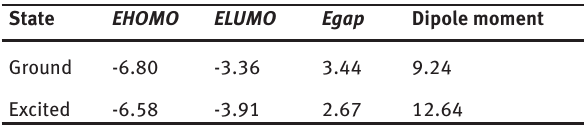
Table 1: HOMO energies ( EHOMO ), LUMO energies ( ELUMO ), HOMO- LUMO energy gap ( Egap ) in (eV) and dipole moment (in Debye) for PBA computed at the B3LYP/6-31G** level of theory.